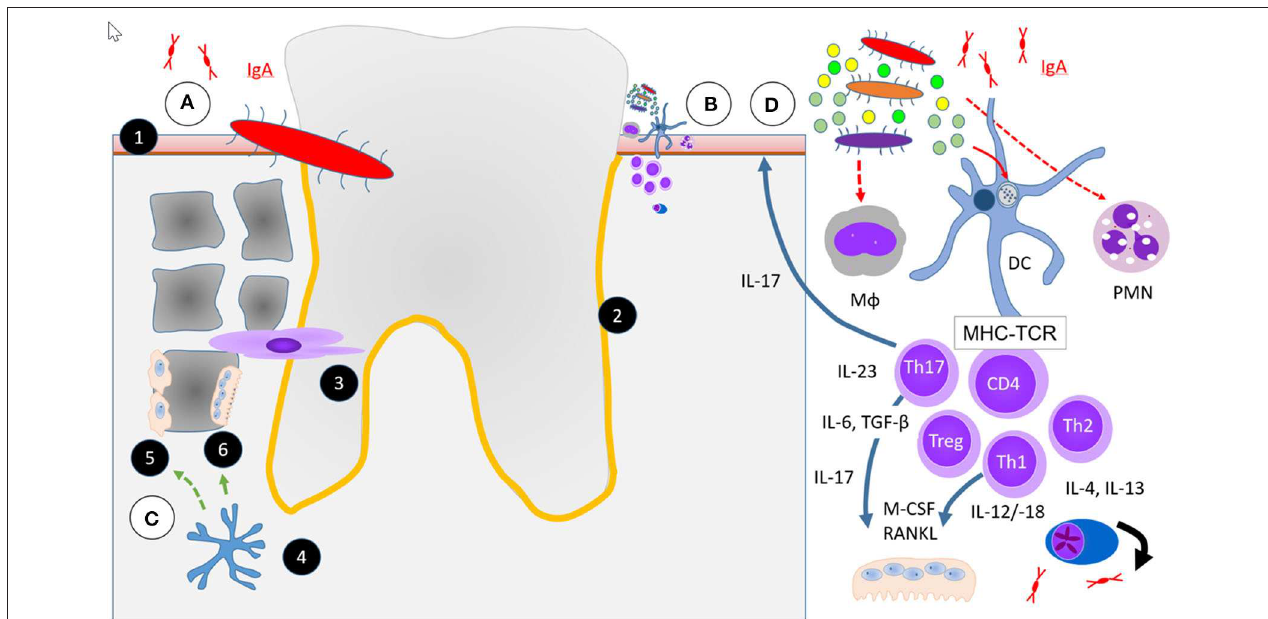
FIGURE 1 | Simplified scheme of four hypotheses or aspects in the etiopathogenesis of periodontitis (PD) relevant to RA. (A) Falsified scenario of a single specific infectious microbial pathogen, i.e., P. gingivalis . (B) Current hypothesis of an increasing multitude of microbes necessary to initiate and maintain PD the polymicrobial synergy and dysbiosis model (PSD) and immune response in RA. (C) Osteoimmunology. (D) Excessive or unresolved inflammatory response. (1) Squamous epithelium, (2) Periodontal space (orange line), (3) Fibroblast periodontal ligament cells, (4) Osteocyte control Wnt-signaling by Sclerostin and DKK-1 (green dashed arrow) in (5) Osteoblasts and activate (6) Osteoclasts by RANKL (green solid arrow). Abbreviations for different immune cells: M φ are macrophages, DC dendritic cells, PMN neutrophils, CD4 + , Th1, Th2, Th17, and Treg are some of a much larger multitude of T cell subsets in PD. MHC, major histocompatibility complex and TCR, T cell receptor represent the immunological synapse of antigen-specific immune response. All other abbreviations of soluble factors are explained in the